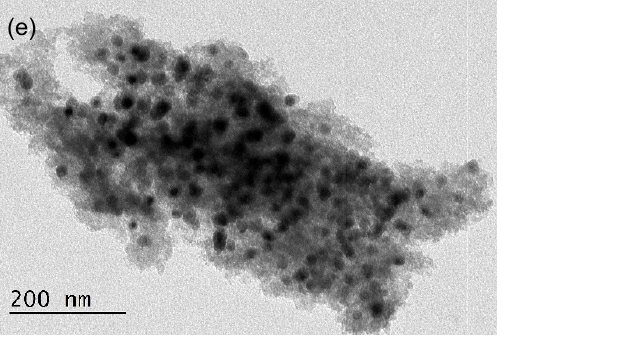
Figure 2. TEM images of the ACM-Fe fresh sample ( a ), the ACM-Fe used sample ( b ), the AC 0 -Fe fresh sample ( c ), the ACH-Fe fresh sample ( d ) and the ACH 900 -Fe fresh sample ( e ).